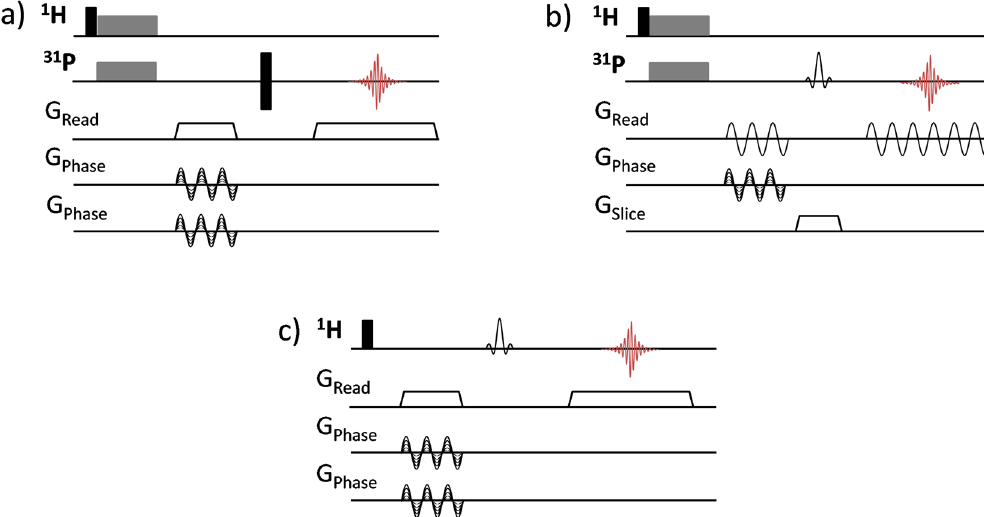
Figure 3. MRI spin-echo sequences used for magic angle spinning ( a ) 3D 31 P CPMAS imaging, ( b ) 2D 31 P CPMAS slice-selective imaging and ( c ) 3D 1 H MAS chemically-selective imaging. Black narrow rectangles correspond to 90° and 180° hard pulses, spin lock block of CP transfer are indicated as grey wide rectangles. The gradient pulses along the MAS axis (z MAS ) are represented as trapezoids and the rotating gradients along the x MAS and y MAS axes, composed of LF gradients with sinusoidal amplitude modulations, are depicted as sinusoidal